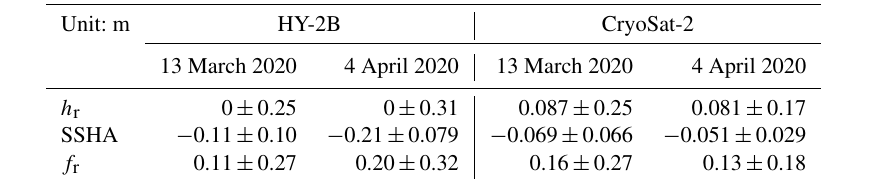
Table 2. Comparison of the mean and standard deviation values of the relative surface elevation ( h r ), sea surface height anomaly (SSHA) and radar freeboard estimates ( f r ) from HY-2B and CryoSat-2.